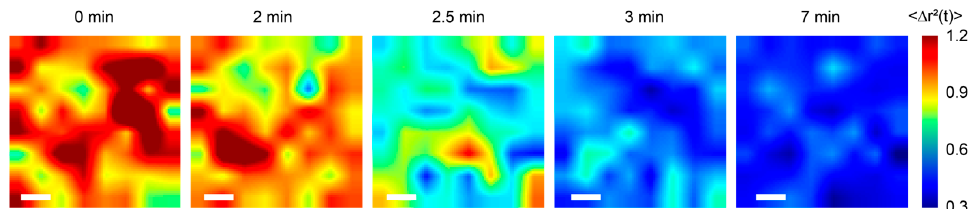
Figure 7. Spatial maps of MSD of the optical vortex at 0, 2, 2.5, 3, and 7 min after kaolin activation. Significant MSD values change at 2–2.5 min and maintain a low level over 7 min in the porcine blood. Scale bar: 200 µm.